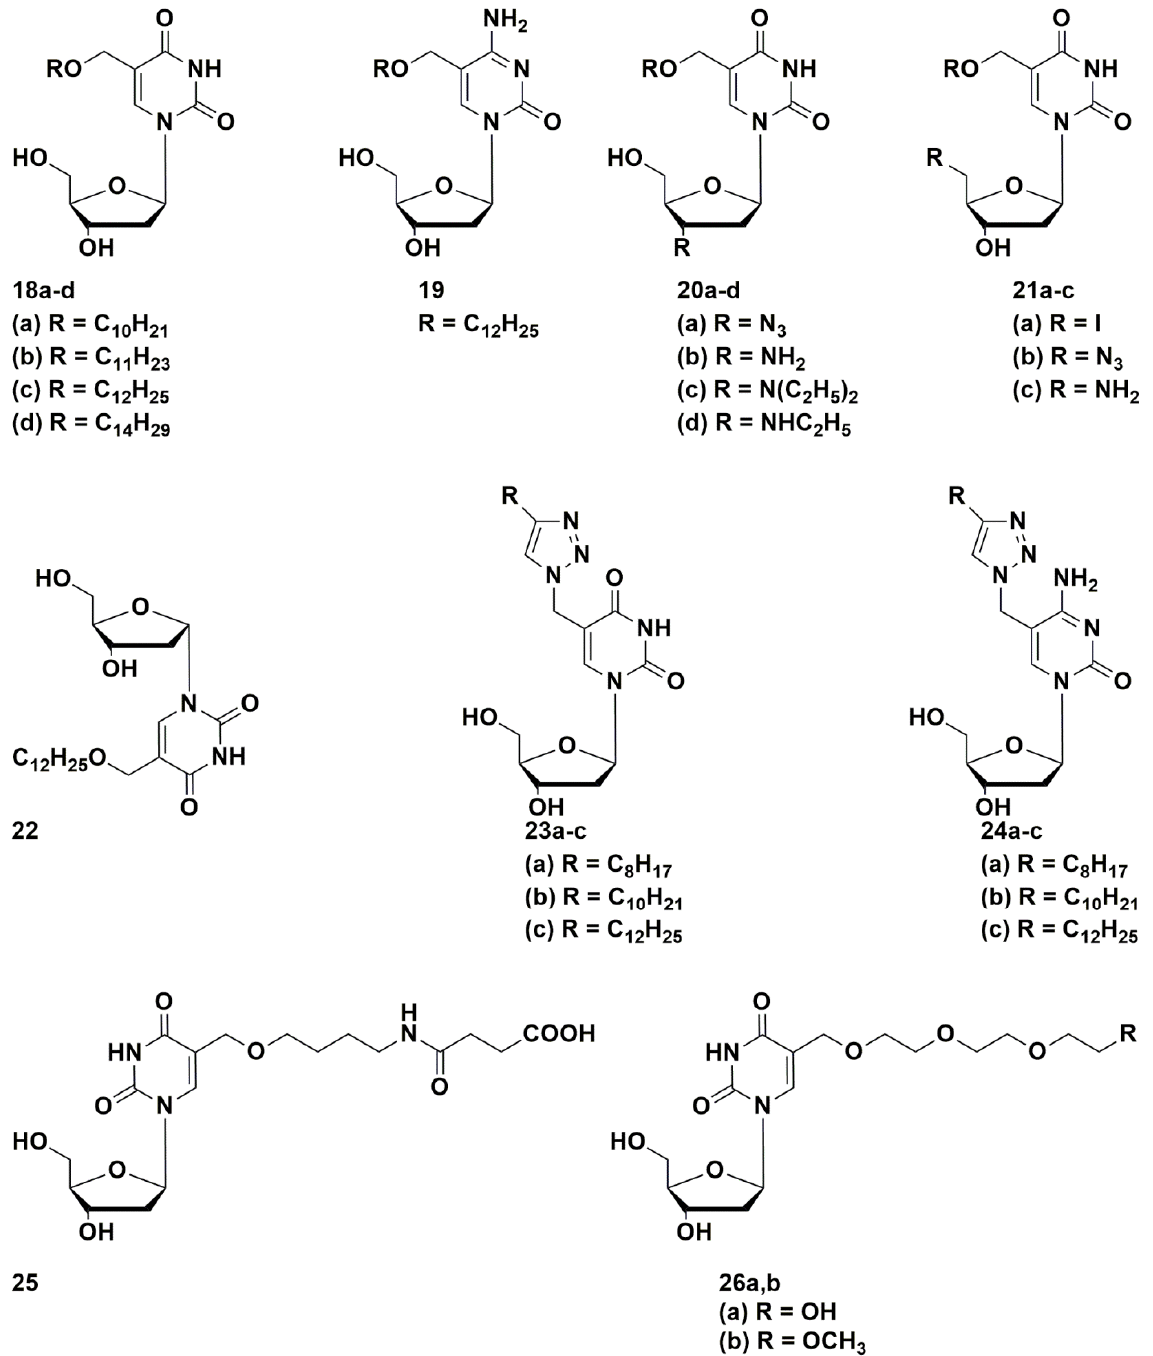
Figure 5. Pyrimidine derivatives of 2 ′ -deoxy-, 3 ′ -azido and 3 ′ -amino-2 ′ ,3 ′ -dideoxynucleosides [42,43].